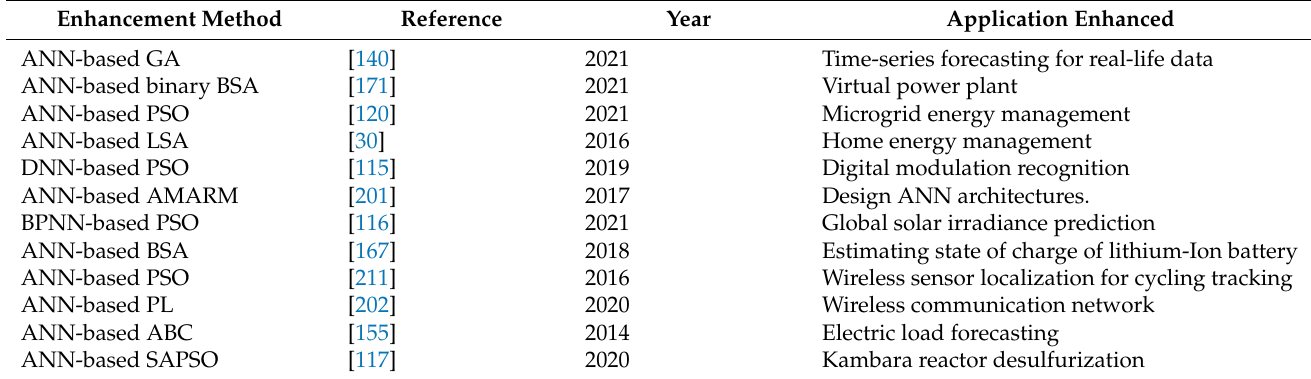
Table 15. Overview of significant studies on NNs based optimization using node numbers in hidden layers and learning